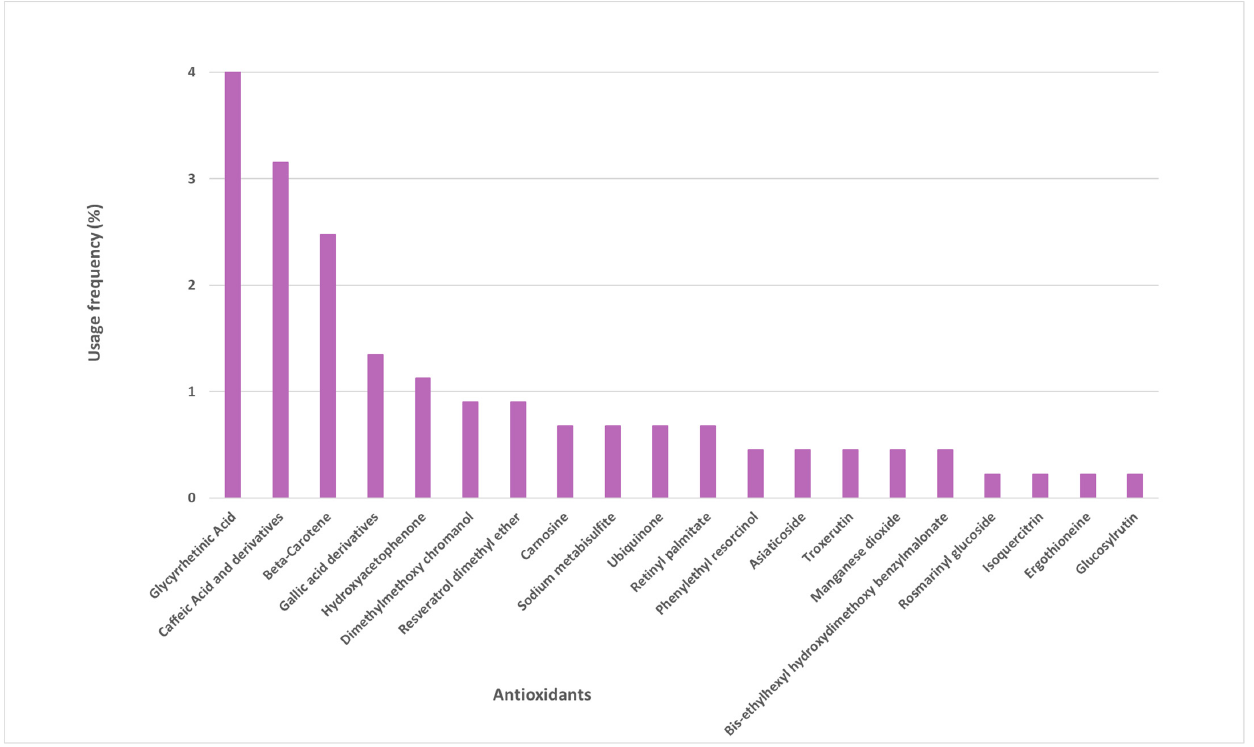
Figure 3. Usage frequency of the remaining antioxidants present in sunscreens.